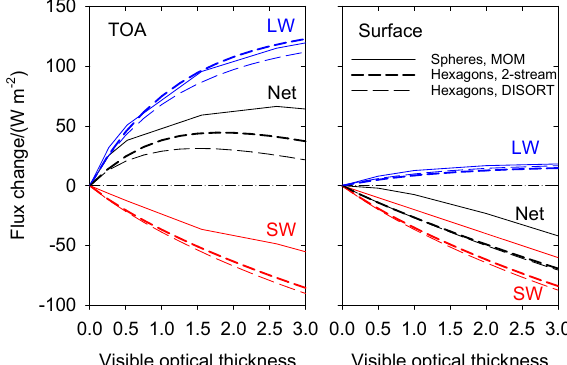
Figure 2. Daily-mean cloud radiative effects from a homogeneous contrail layer at 10 to 11km altitude versus 550nm optical thick- ness. The contrail cirrus is assumed to be composed of spheres (Meerkötter et al., 1999) or hexagons (Fu and Liou, 1993). The cloud radiative effect is the flux difference relative to the cloud-free atmosphere and computed with matrix operator method (MOM; Plass et al., 1973), two-stream and discrete ordinate (DISORT) solvers, and the Fu and Liou parameterization for molecular absorp- tion, for daily mean at 45 ◦ N on 21 June, standard midlatitude sum- mer atmosphere, over a surface with albedo 0.2, and fixed surface temperature (294.2K). Differences between the SW (LW) fluxes from the two-stream and DISORT solvers are <6% (<19%).